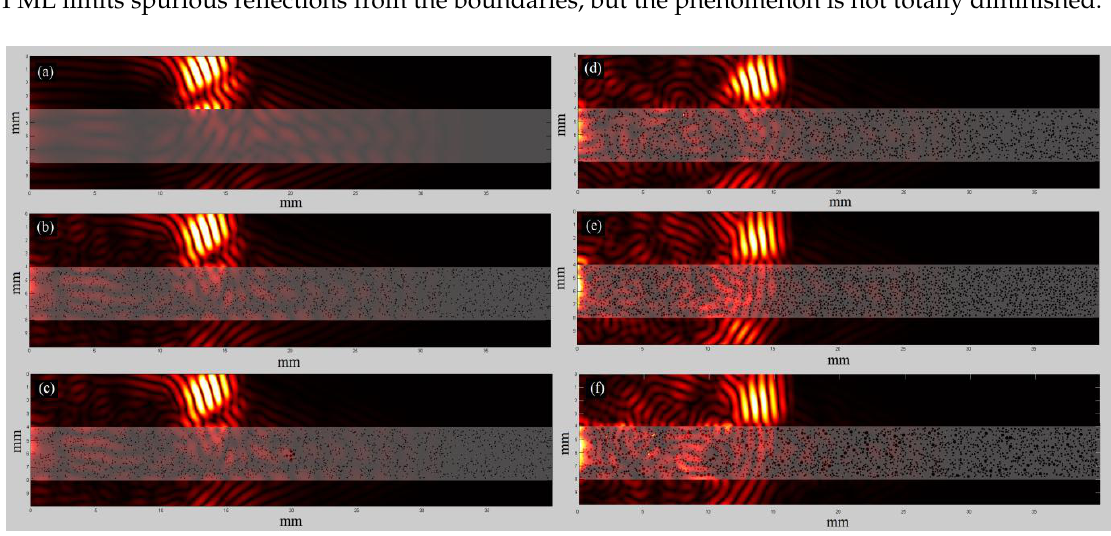
Figure 6. Snapshots of wave propagation for the first set of simulations using non-contact transducers for the excitation frequency of 1 MHz and time instant 10 μs for the cases: ( a ) B_Hom; ( b ) B_Po5;